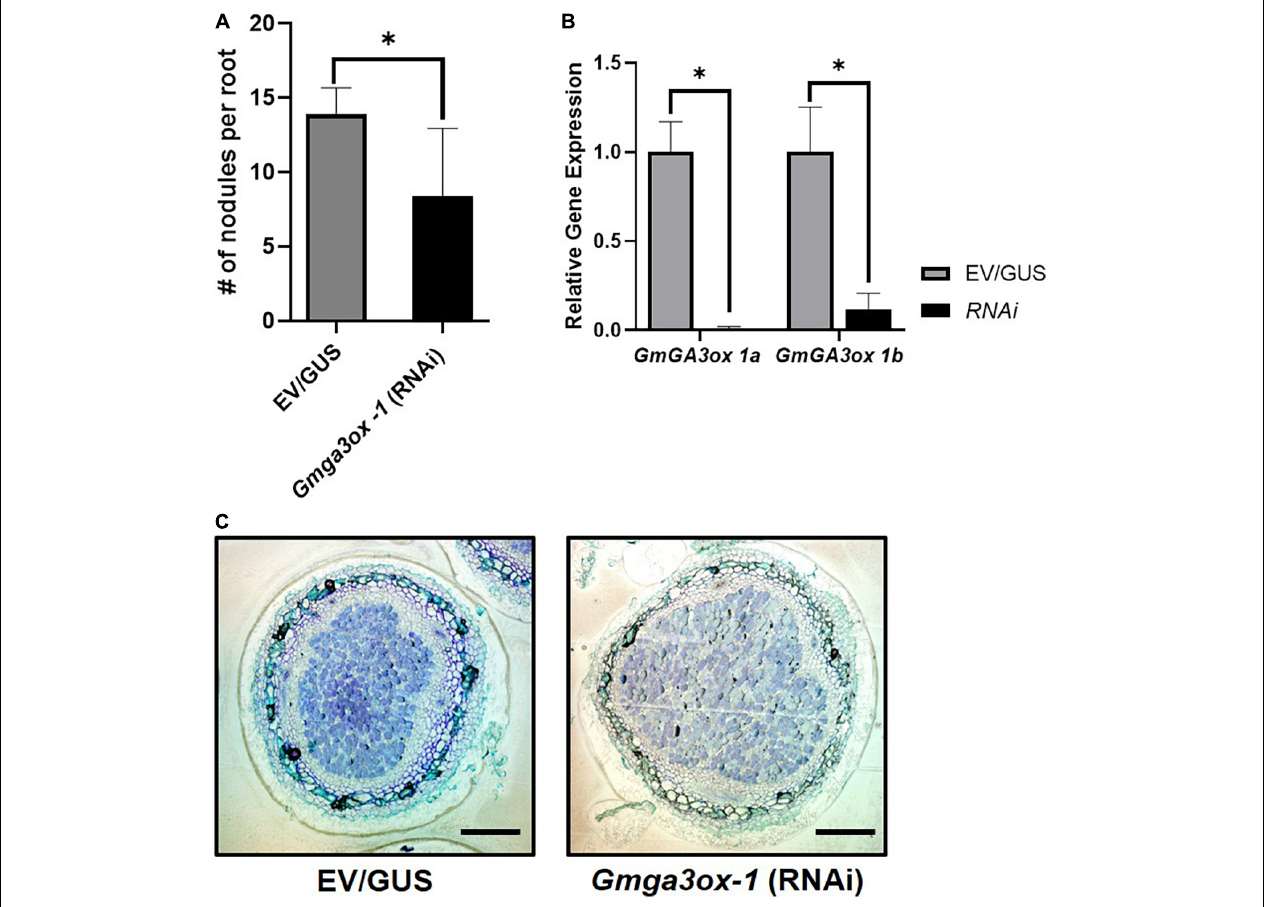
FIGURE 4 | Quantification of relative nodule numbers and nodule structure in the Gmga3ox 1 -RNAi transgenic hairy root. (A) Study of Gmga3ox 1 -RNAi transgenic hairy root nodule density (Nodule number/Root fresh weight) in comparison to control vector (GUS) transgenic hairy root. (B) Relative gene expression of GmGA3ox-1a and GmGa3ox-1b in RNAi transgenic hairy root. (C) Nodule structure of Gmga3ox-1 -RNAi transgenic hairy root after 21 days post-inoculation of B. japonicum . Error bar represents ± SE and ∗ indicates t -test significance at P < 0.001 (scale bar = 200 µ